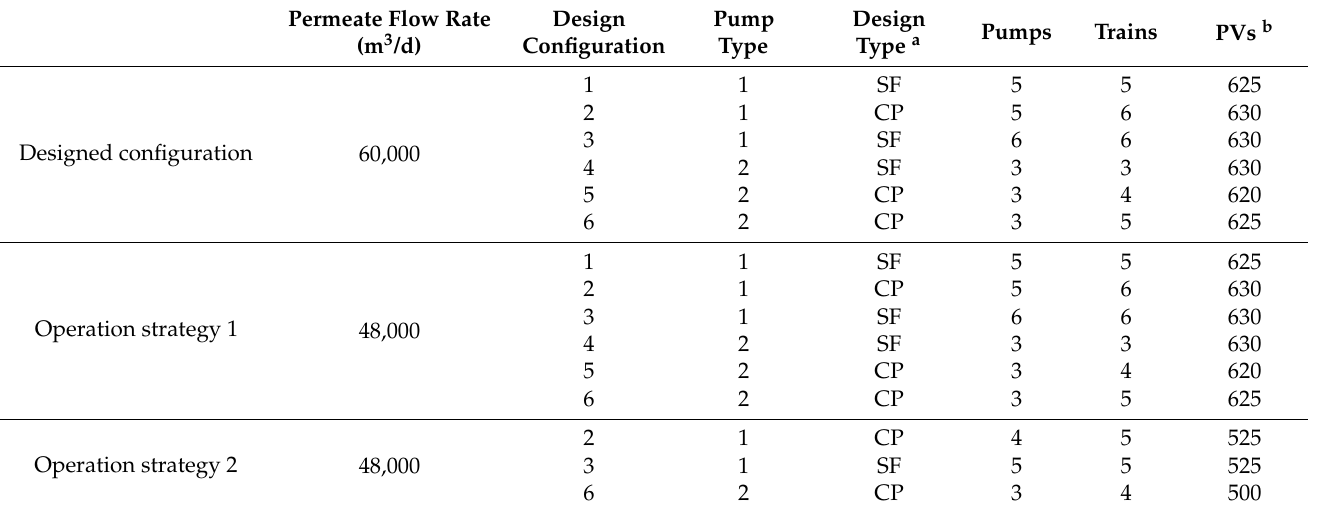
Table 3. Design and operation configuration employed during the optimization and simulation of reverse osmosis for a single-pass SWRO system. Permeate Flow Rate Design